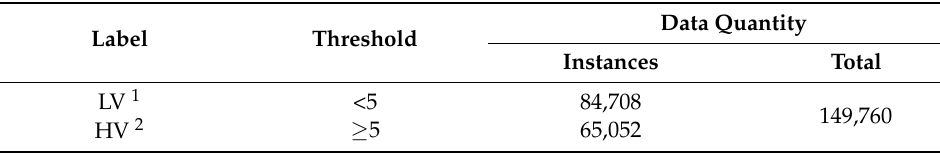
Table 1. Sample distribution on the valence classification task.